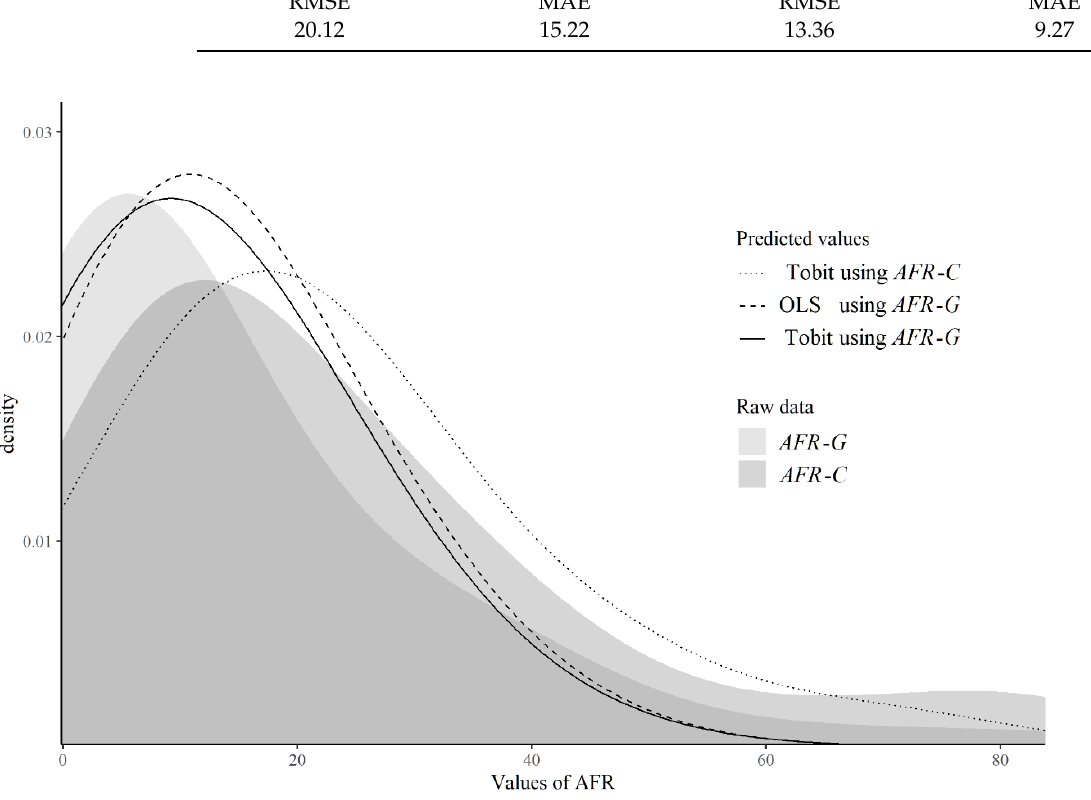
Figure 5. Kernel density estimation of raw data and predicted values.